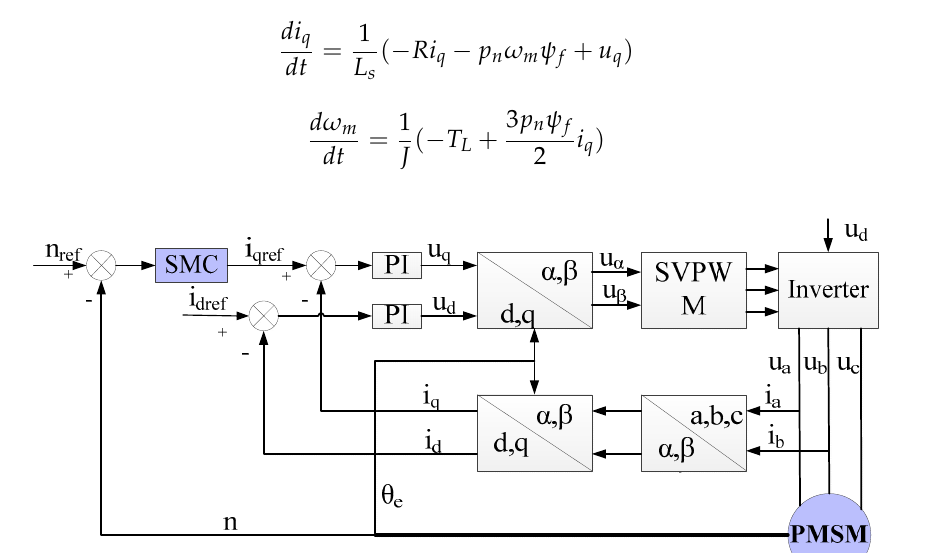
Figure 1. A typical vector control of permanent magnet synchronous motors (PMSMs).